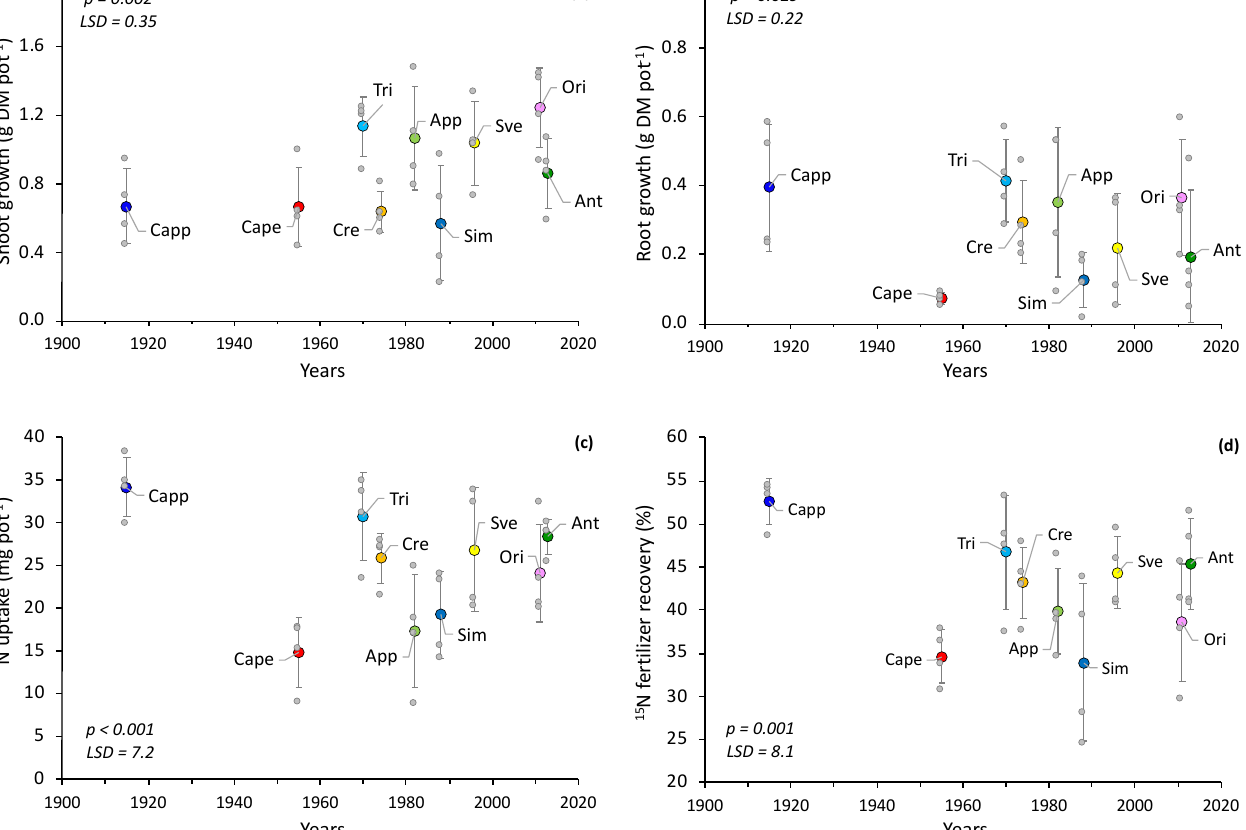
Figure 2. Relationships between shoot growth ( a ), root growth ( b ), N uptake ( c ) and 15 N fertilizer recovery ( d ) 7 days after the application of N fertilizer (Time 2) and the year of release of the nine studied genotypes. For each trait the p value and LSD (Fisher’s LSD test, p = 0.05) are reported. All genotype data are plotted with the mean depicted as a colored circle ± standard deviation ( n = 4) represented by the end of the vertical black line. N, nitrogen; LSD, least significant difference; DM, dry